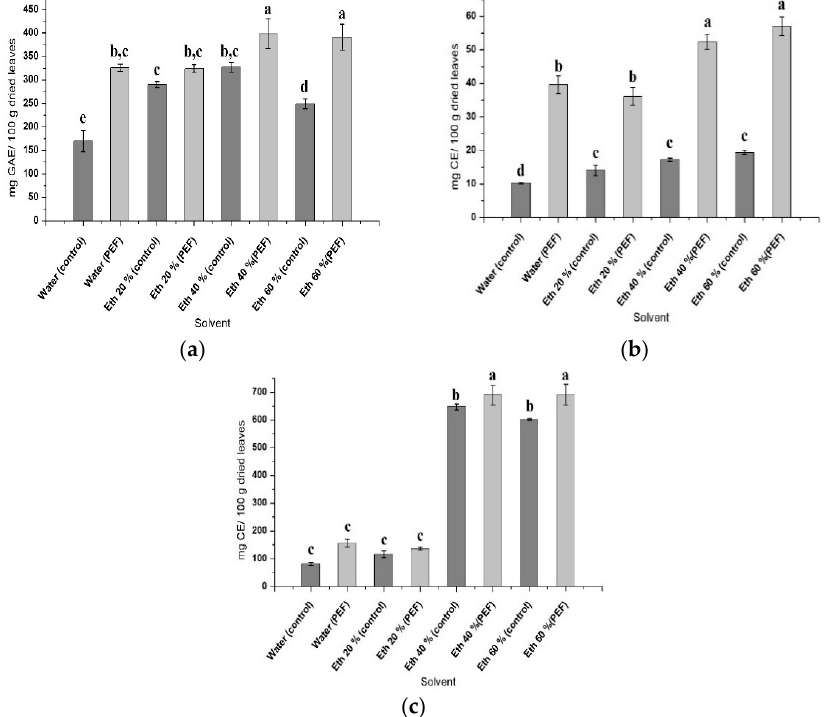
Figure 4. Variation of the phenolic compound extraction yield as a function of the ethanol concen- tration. ( a ) Total phenolic content; ( b ) Total flavonoid content; (c) Condensed tannin content. Means not sharing any letters are significantly different.